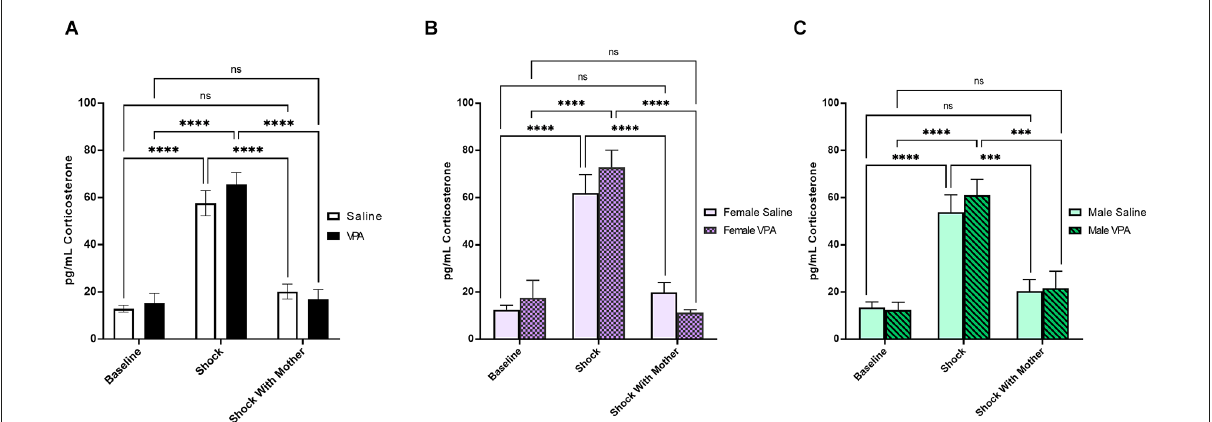
FIGURE5 (A) Maternal buffering of stress response to shock at P6–7. Data expressed as mean ± standard error of the mean. We observed a significant main effect of experimental condition, p < 0.0001 on pup corticosterone levels. Both saline and VPA-treated pups exposed to shock showed significantly higher corticosterone levels than baseline groups ( p ’s < 0.0001) and the groups exposed to shock in the presence of a calm mother ( p ’s < 0.0001). (B) Maternal buffering of stress response to shock in females at P6–7. Data expressed as mean ± standard error of the mean. We observed a significant main effect of experimental condition, p < 0.0001 on female pup corticosterone levels. Both saline and VPA-treated female pups exposed to shock showed significantly higher corticosterone levels than baseline groups ( p ’s < 0.0001) and the groups exposed to shock in the presence of a calm mother ( p ’s < 0.0001). (C) Maternal buffering of stress response to shock in males at P6–7. Data expressed as mean ± standard error of the mean. We observed a significant main effect of experimental condition, p < 0.0001 on male pup corticosterone levels. Both saline and VPA-treated male pups exposed to shock showed significantly higher corticosterone levels than baseline groups ( p ’s < 0.0001) and the groups exposed to shock in the presence of a calm mother (saline p = 0.0001, VPA p = 0.0003). ∗∗∗ p = 0.0001–0.001; ∗∗∗∗ p < 0.0001; ns = p >